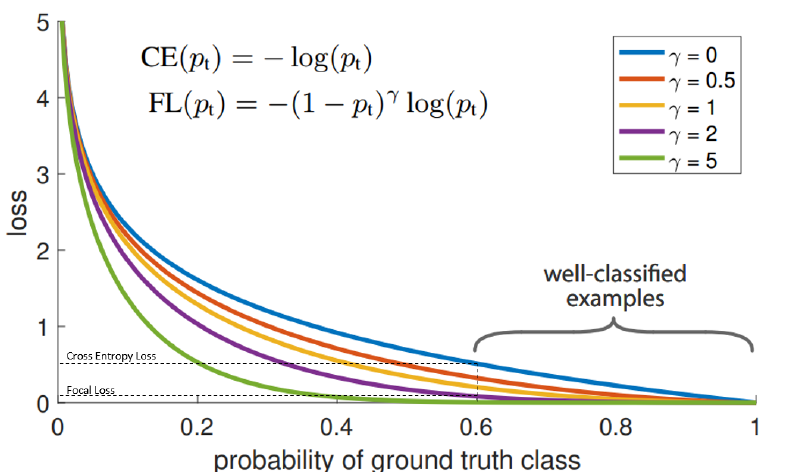
Figure 11. Comparison between Focal Loss with different focusing parameter γ values and the Cross-Entropy Loss function